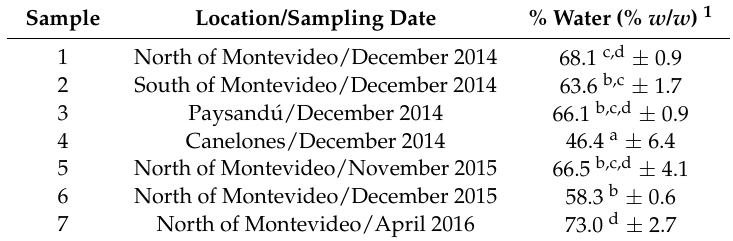
Table 1. Water content calculated by weighing the samples before and after